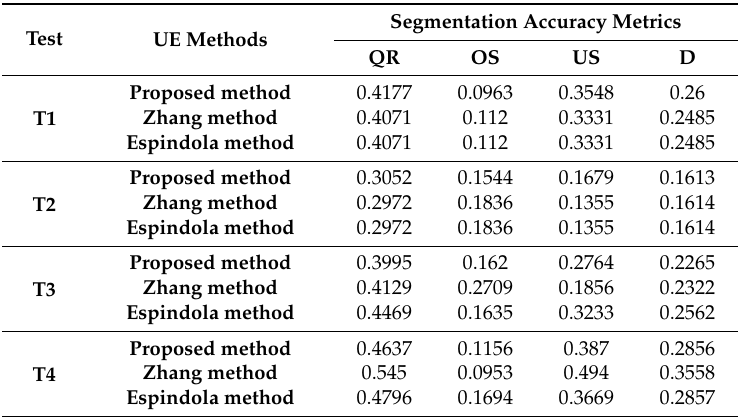
Figure 11. The UE results of the segmentations produced by the MRS method with the different UE methods for the four study areas: ( a ) T1, ( b ) T2, ( c ) T3, and ( d ) T4. Table 2. The supervised evaluation (SE) results for the segmentations produced with the different unsupervised evaluation (UE) methods.